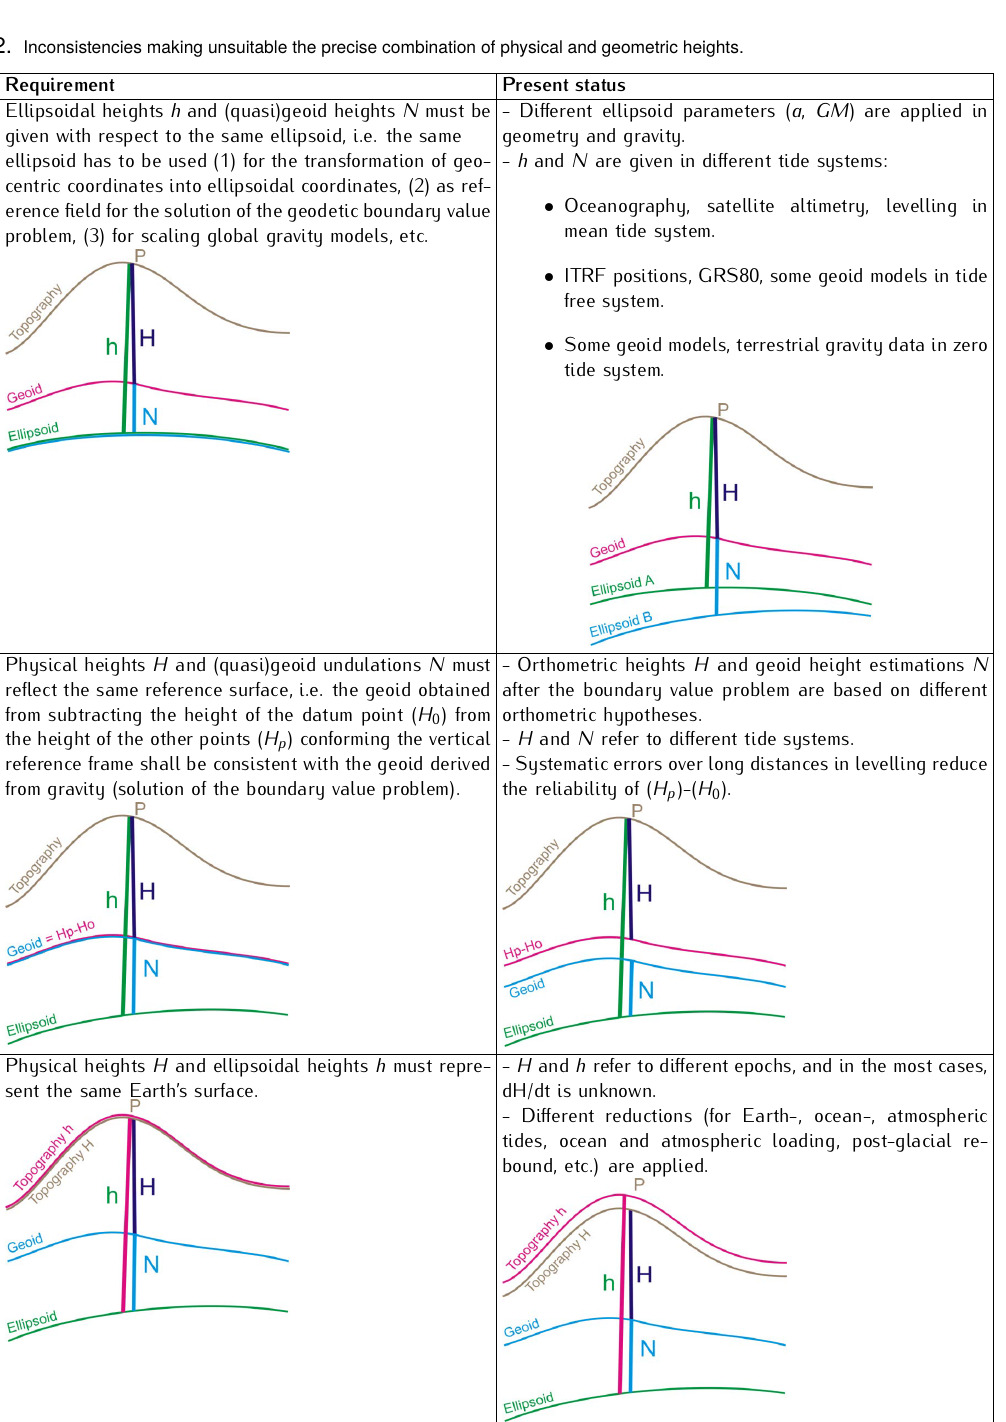
- Different ellipsoid parameters ( a , GM ) are applied in geometry and gravity.